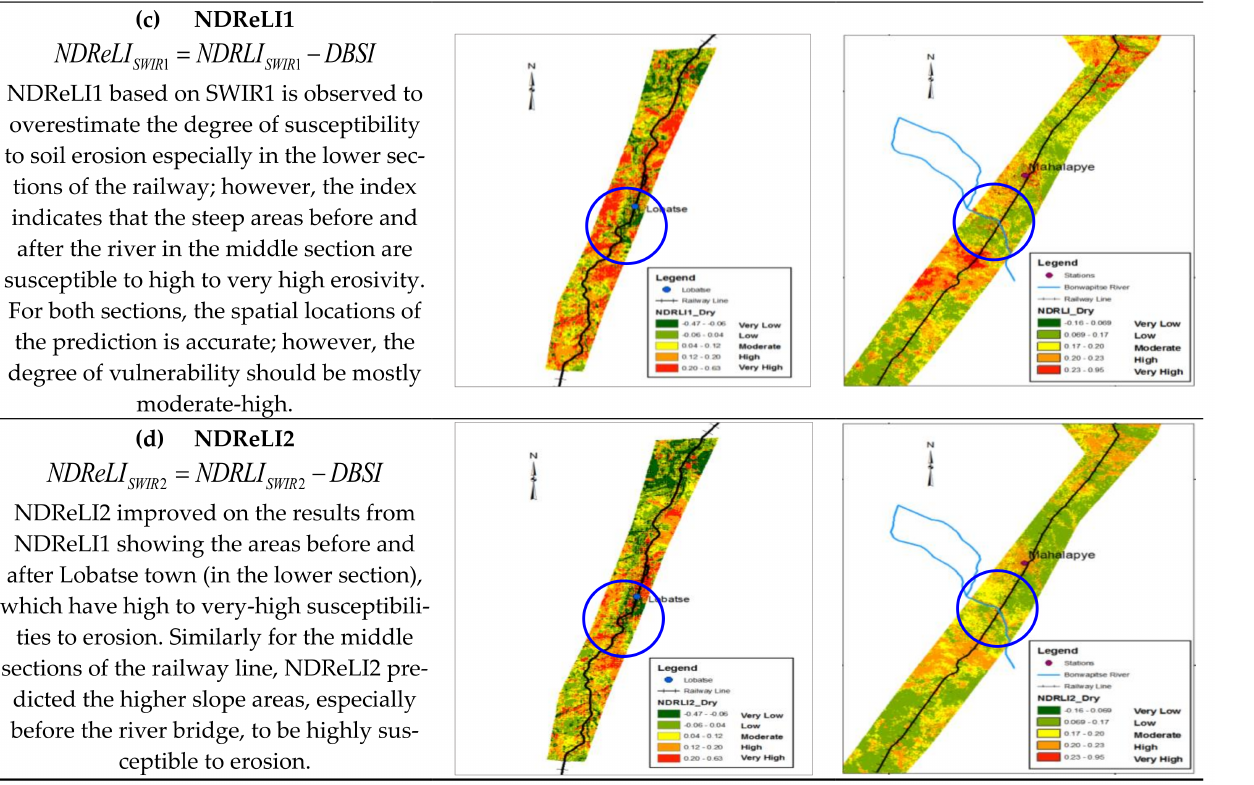
Figure 12. Soil loss validation maps. (The circled areas represent the validation sites within the corridor, and only predicted erosion events that run across the railway line are considered as